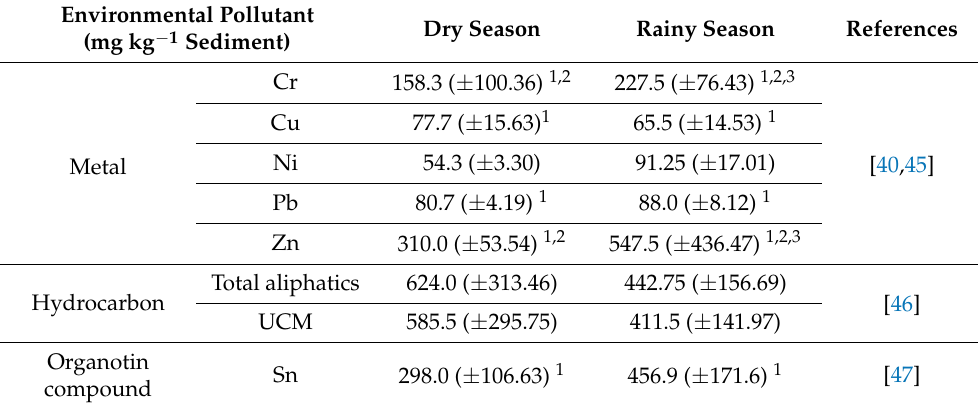
Table 1. The concentration of metals, hydrocarbons, and organotin compounds detected in the surface sediments of the estuarine region of Guanabara Bay, where snails were collected. Data compiled from the same study are presented as mean ( ± standard deviation) of replicates of sediment collected at the estuarine region of Guanabara Bay in the same period (dry or rainy